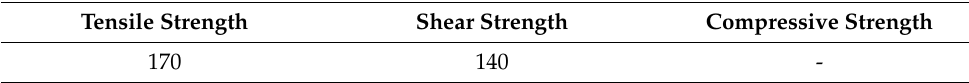
Table 4. Basic mechanical parameters of bolt (unit: